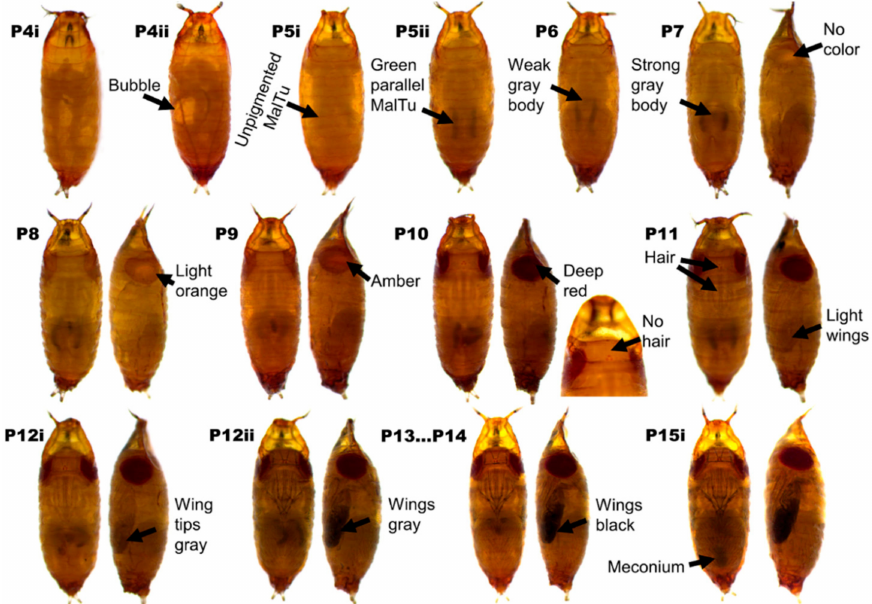
Figure 2. D. guttifera pupal developmental stages are labeled as described by Bainbridge and Bownes [25] for D. melanogaster and adopted for D. guttifera by Werner et al. [6]. (MaITu stands for Malpighian